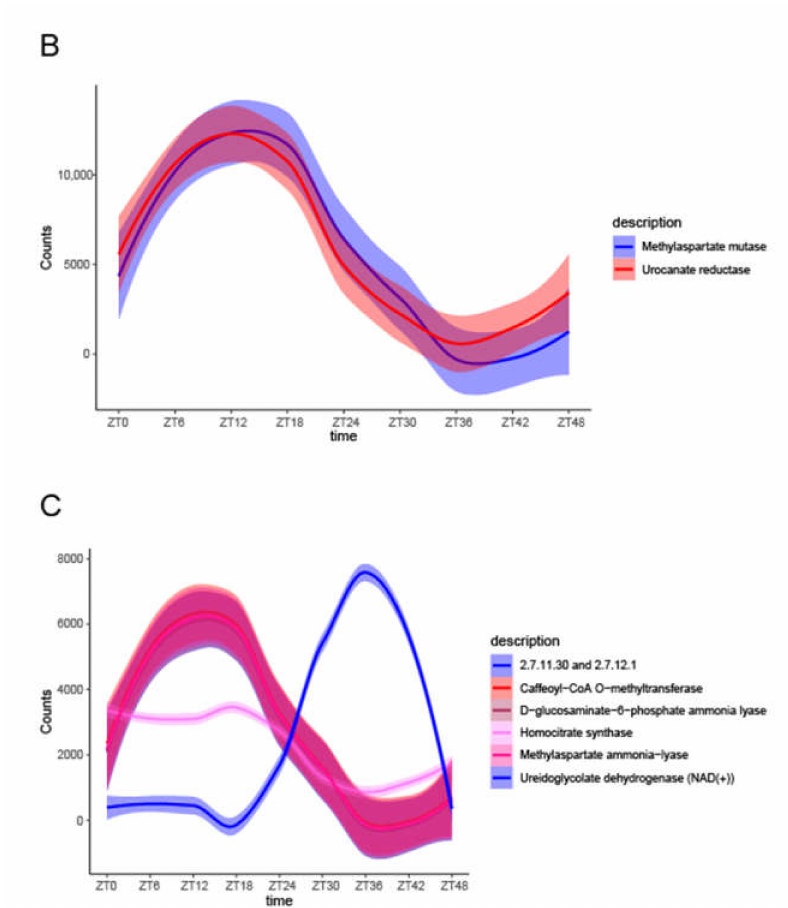
Figure 5. The most abundant enzymes were identified by random forest analysis. ( A ) Tracing the source of the top 30 most abundant enzymes in the fecal microbiota; ( B , C ) The temporal changes in the contributing